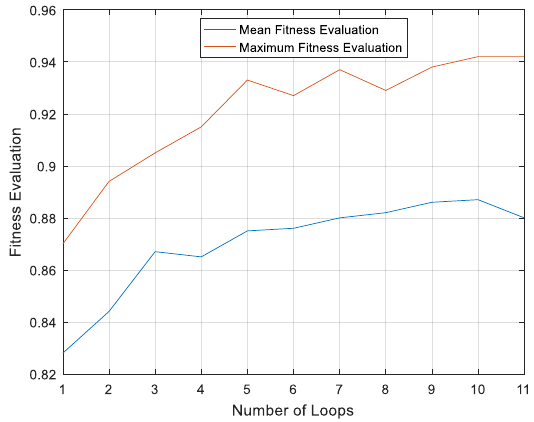
Figure 9. Simulation results of PGE-NN with 30 neurons.